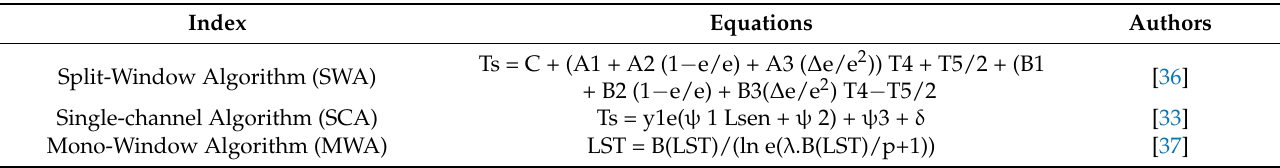
Table 4. Equations of LST estimation algorithms.